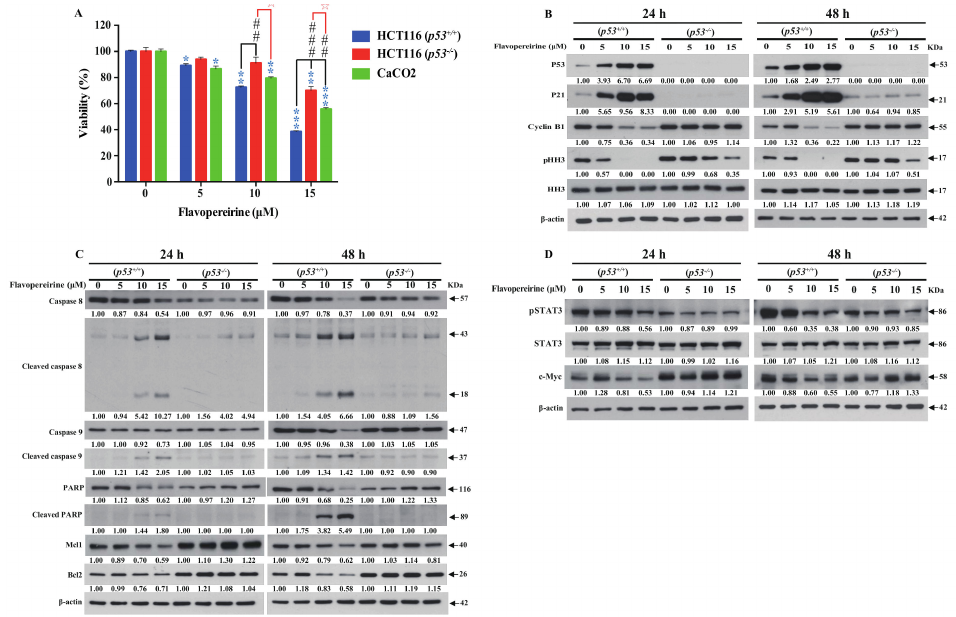
Figure 5. P53 signaling participated in flavopereirine-mediated viability reduction and apoptosis induction. HCT116 p53 +/+ , p53 − / − and CaCO 2 cells were treated with flavopereirine for 48 h. ( A ) Cell viability was determined by CCK8 assay. Each value was the mean ± SD of quadruplicate assays. * p < 0.05; ** p < 0.01, *** p < 0.001 compared to each untreated control. ## p < 0.01 and ### p < 0.001 compared to flavopereirine (10 or 15 µ M) treated HCT116 ( p53 +/+ ) group. (cid:80) p < 0.05 and (cid:80)(cid:80) p < 0.01 compared to flavopereirine (10 or 15 µ M) treated HCT116 ( p53 − / − ) group. ( B – D ) Pro-apoptotic, anti-survival, G2 / M-phase cell cycle, and STAT3 signaling were not changed in HCT116 ( p53 − / − ) cells relative to wild type HCT116 ( p53 +/+ ) cells after flavopereirine treatment for 24 h and 48 h. Numbers under the plots indicate the fold change of protein level relative to their untreated control. Similar results were obtained in at least three independent